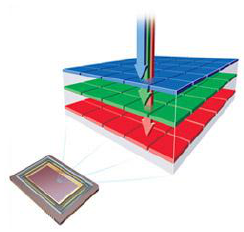
Figure 2. A schematic of the Foveon X3